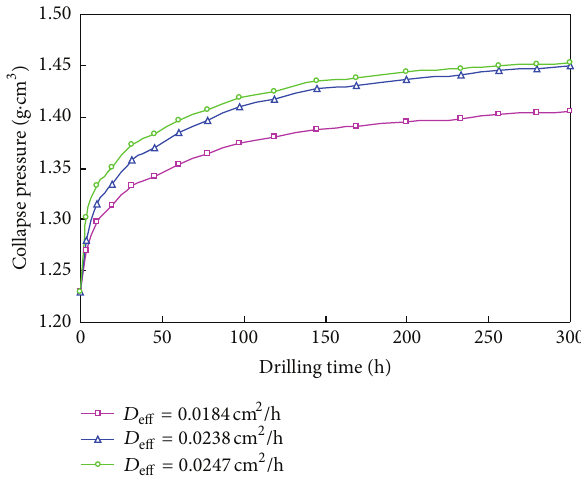
Figure 9: Time-dependent collapse